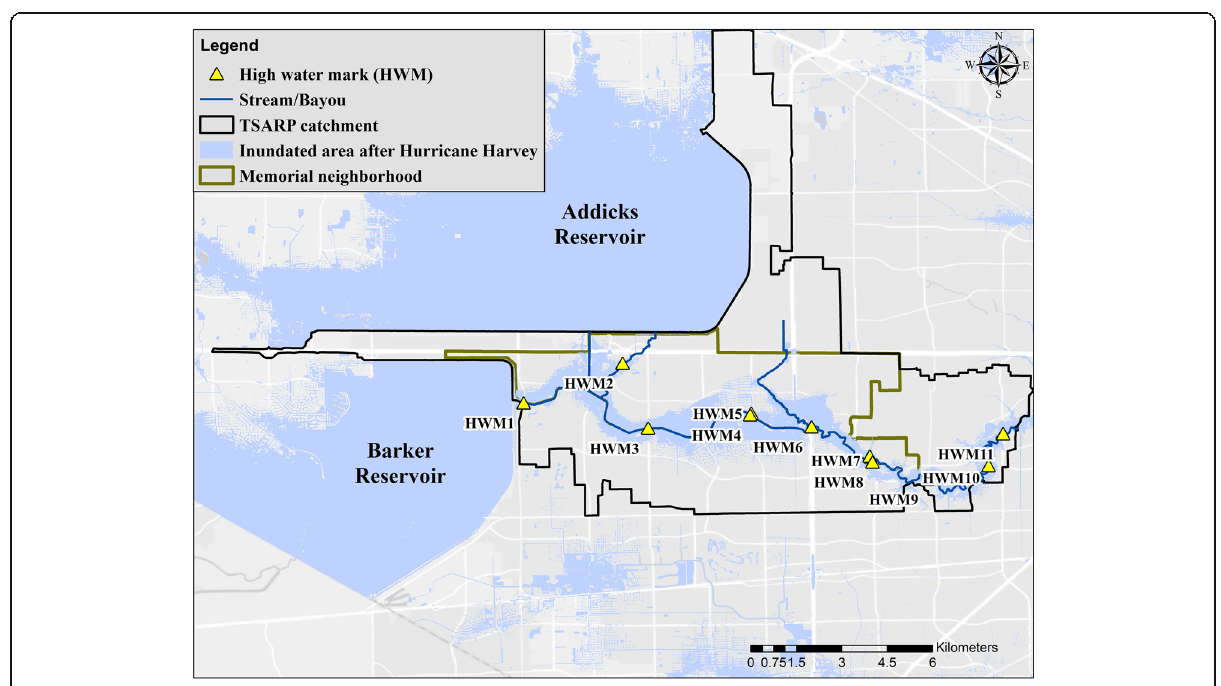
Fig. 2 Study area and location of High-Water Marks (HWMs) used in the